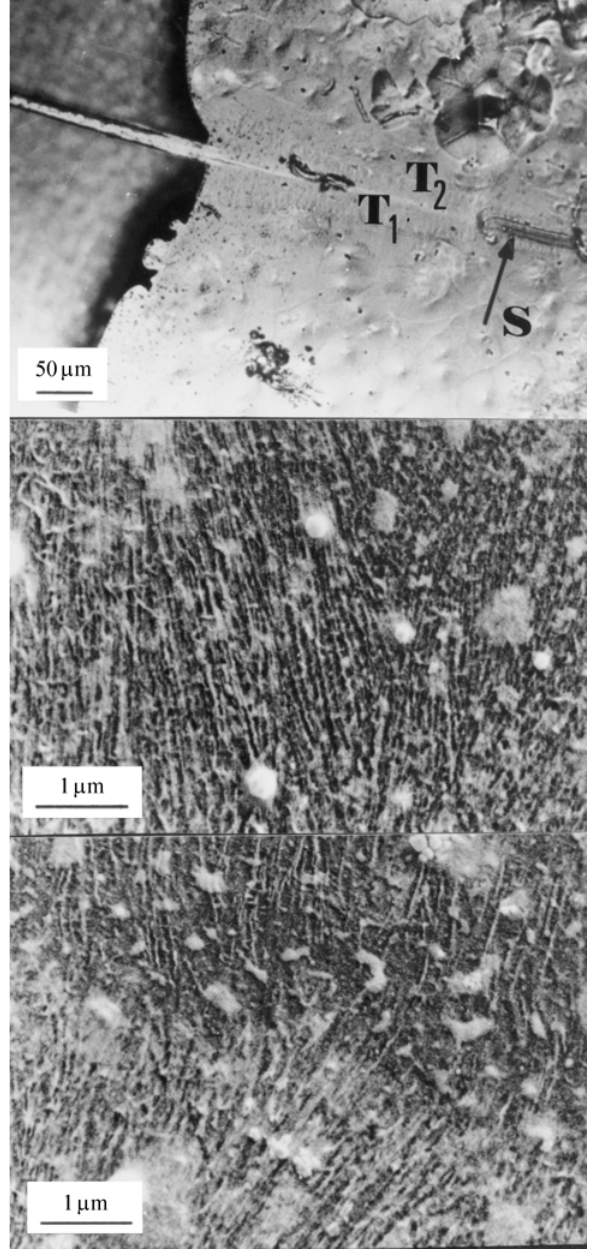
Figure 7. Approximate sample locations for the observation of lamellar (b). Original magnification 300X in (a), 1500X in